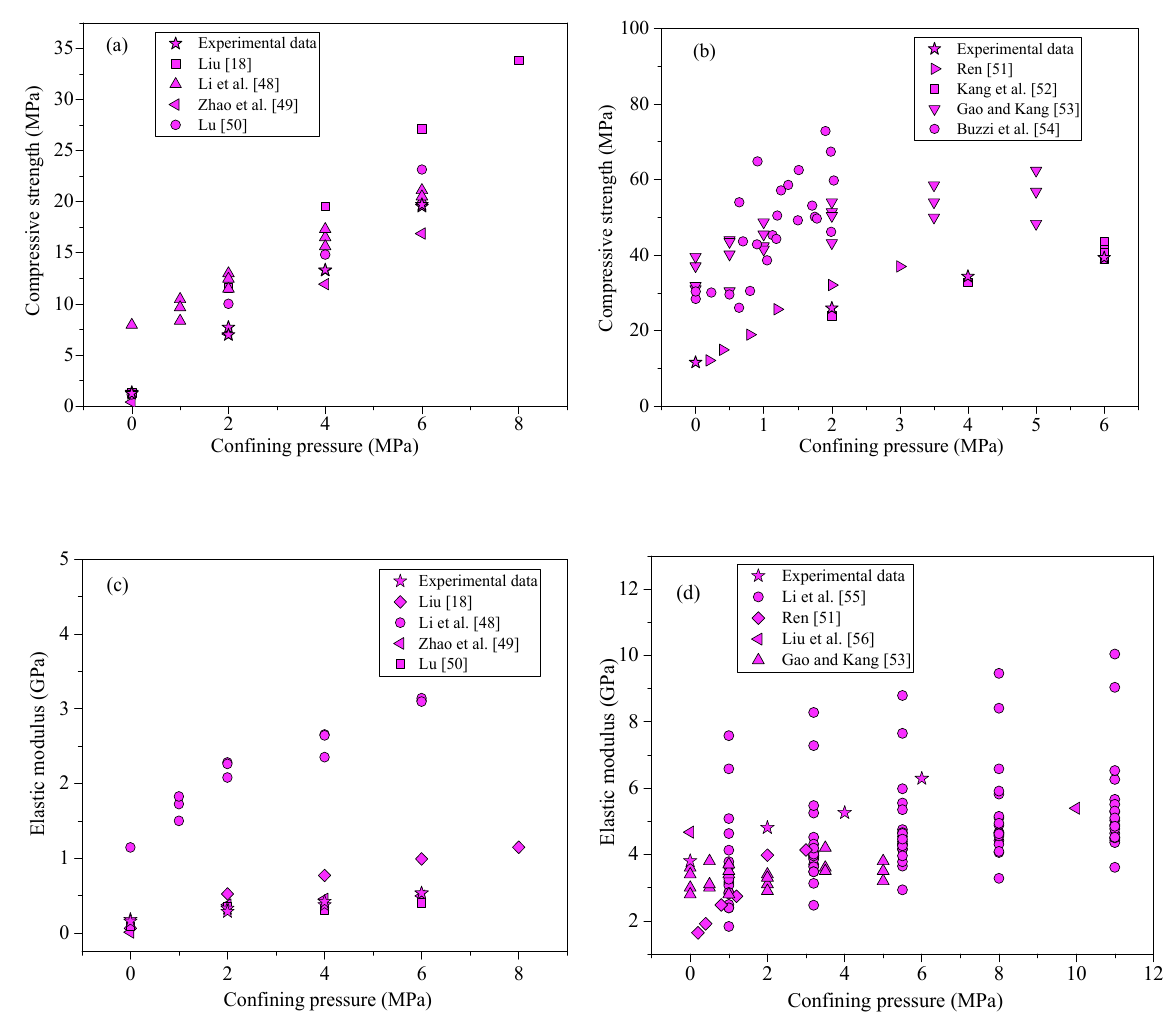
Figure 14. The difference of mechanical properties between RTC and intact coal. ( a ) Compressive strength of RTC [18,48–50]; ( b ) compressive strength of intact coal; [51–54]; ( c ) elastic modulus of RTC [18,48–50]; ( d ) elastic modulus of intact Figure 14 . The difference of mechanical properties between RTC and intact coal. (a) Compressive strength of RTC [18,48–50]; (b) coal compressive strength of intact coal;[51–54] (c) elastic modulus of RTC [18,48–50]; (d) elastic modulus of intact coal [51,53,55,56].